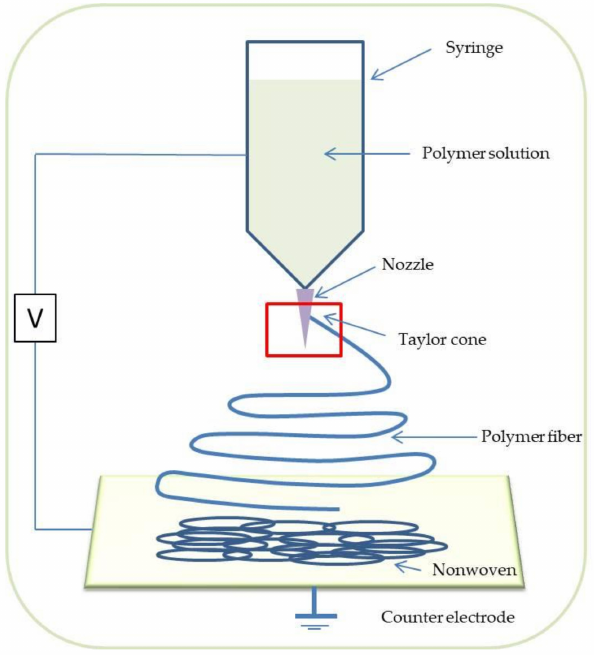
Figure 4. Scheme illustration of electrospinning